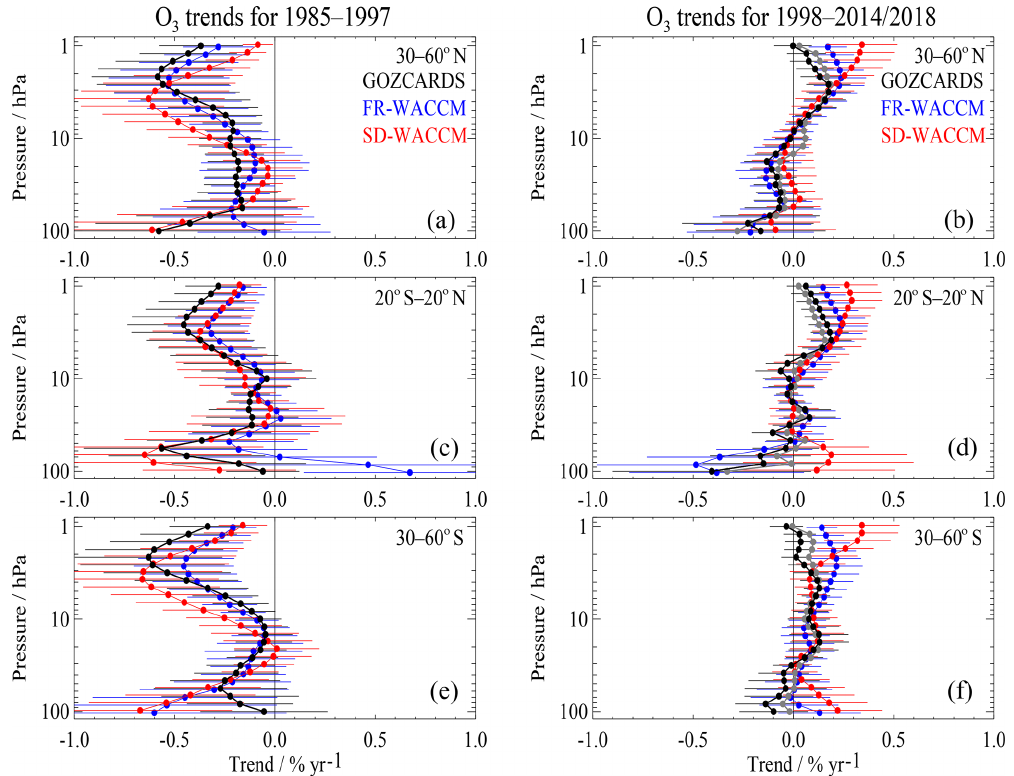
Figure 21. Same as Fig. 19 for ozone trend comparisons, except for the use of longer-term GOZCARDS (version 2.20) ozone data records, with 1985–1997 shown in (a, c, e) and 1998–2014 in (b, d, f) , along with the corresponding model results. We also show the updated ozone data trends with 1998–2018 results in grey (for b, d, f